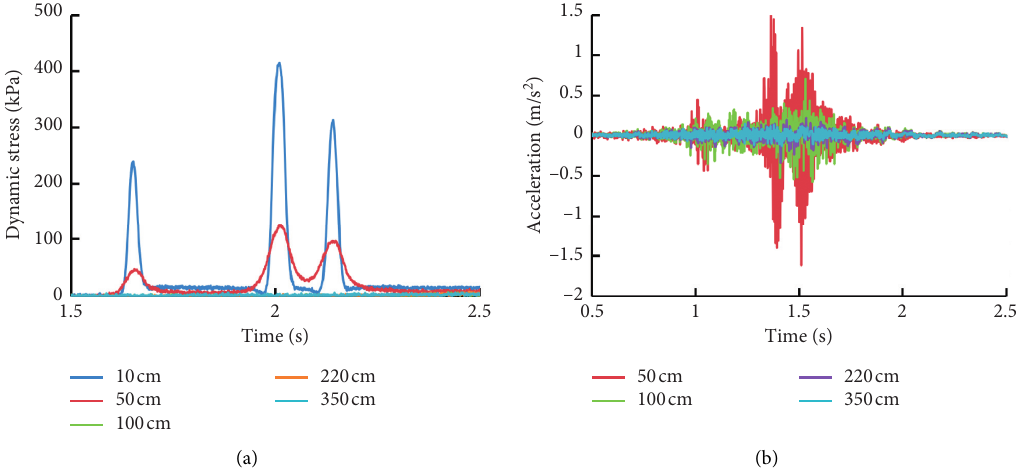
Figure 6: Typical time-history curves of dynamic stress and acceleration: (a) dynamic stress time-history curve, and (b) acceleration time- history curve.